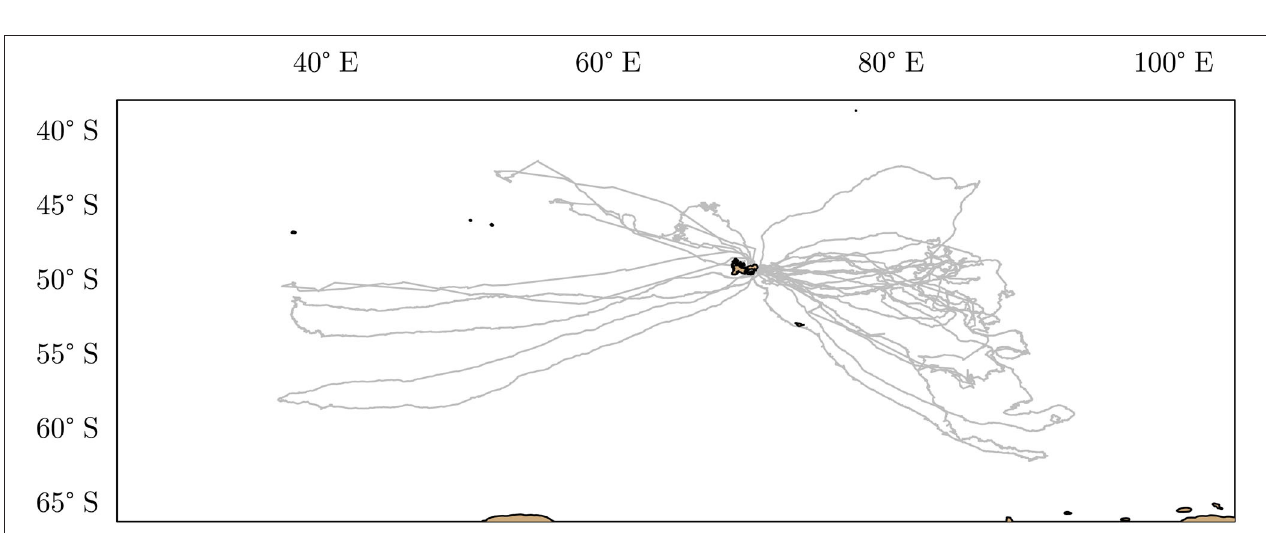
FIGURE 2 | Workflow of functional data analysis for the study of diving behavior of Mirounga leonina . Time-depth sampled profiles (a) can be approximated with continuous curves by a linear combination of K known functions (b) . This first step reduces the dimensionality of the initial data and provides a new data frame. Observations are projected with PCA in a space of small dimensions using a number Q of principal component scores. Each component reflects a specific deformation of the shape of curves (c) . By construction, deformations are independent, and their magnitude can be ordered according to a percentage of explained variance. PCA scores are used as inputs for model-based clustering in order to identify characteristic shapes of sampled curves ( G 1, G 2, G 3, and G 4) (d) .